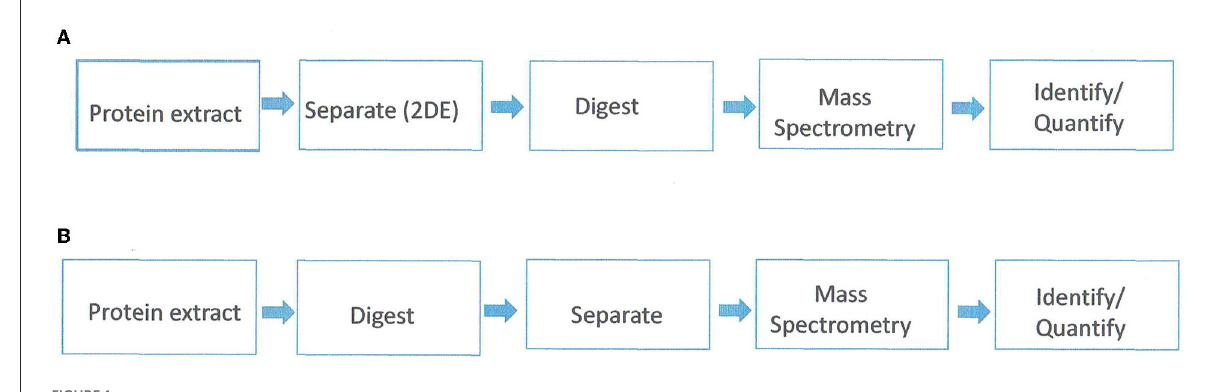
FIGURE1 Proteomics/mass spectrometric workflow. (A) gel-based approach. (B) gel-free approach. Adapted from Petreschi et al.